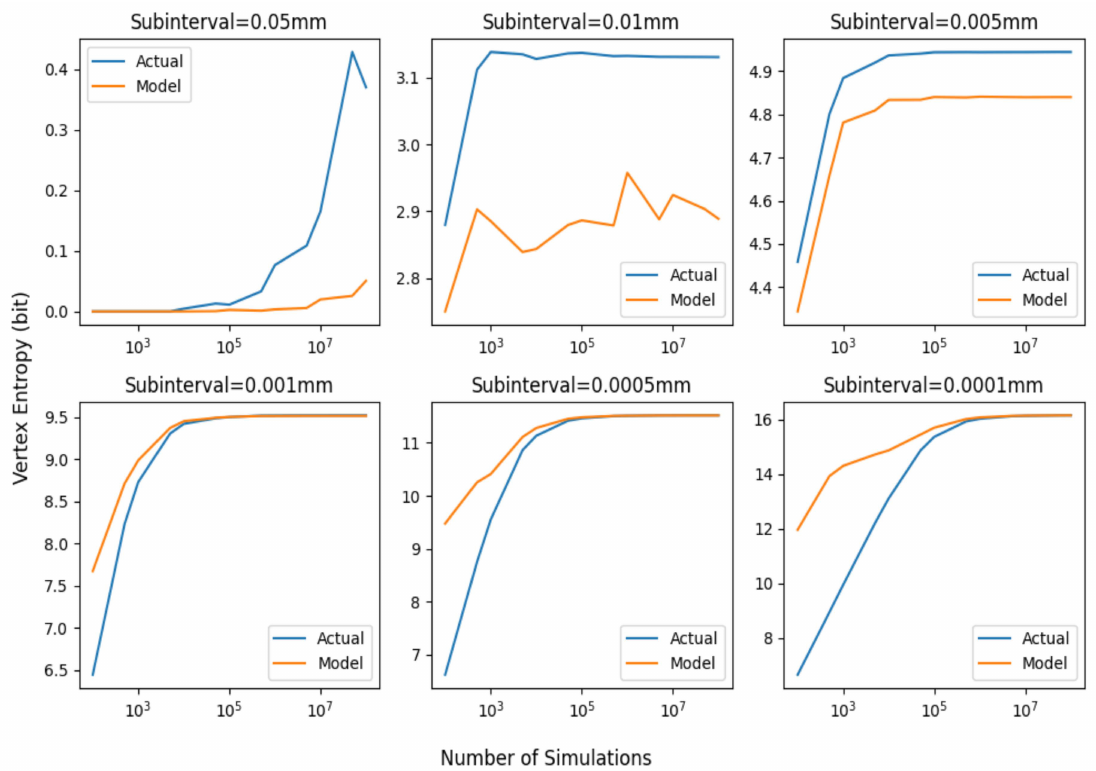
Figure 10. The simulation results Example